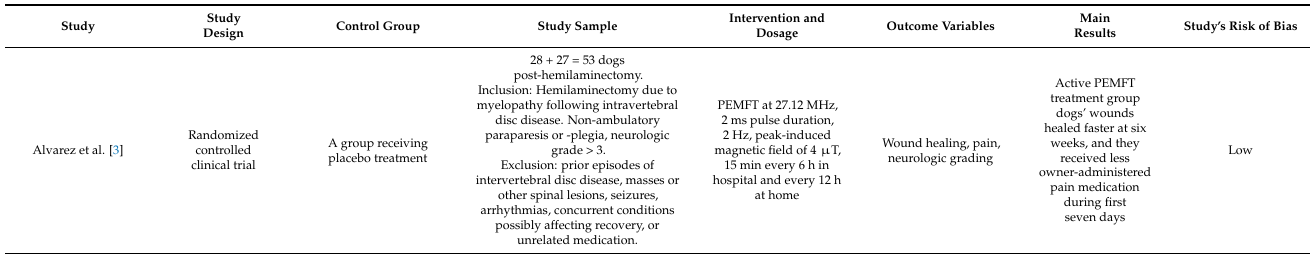
Table 2. Review of articles regarding pulsed electromagnetic field